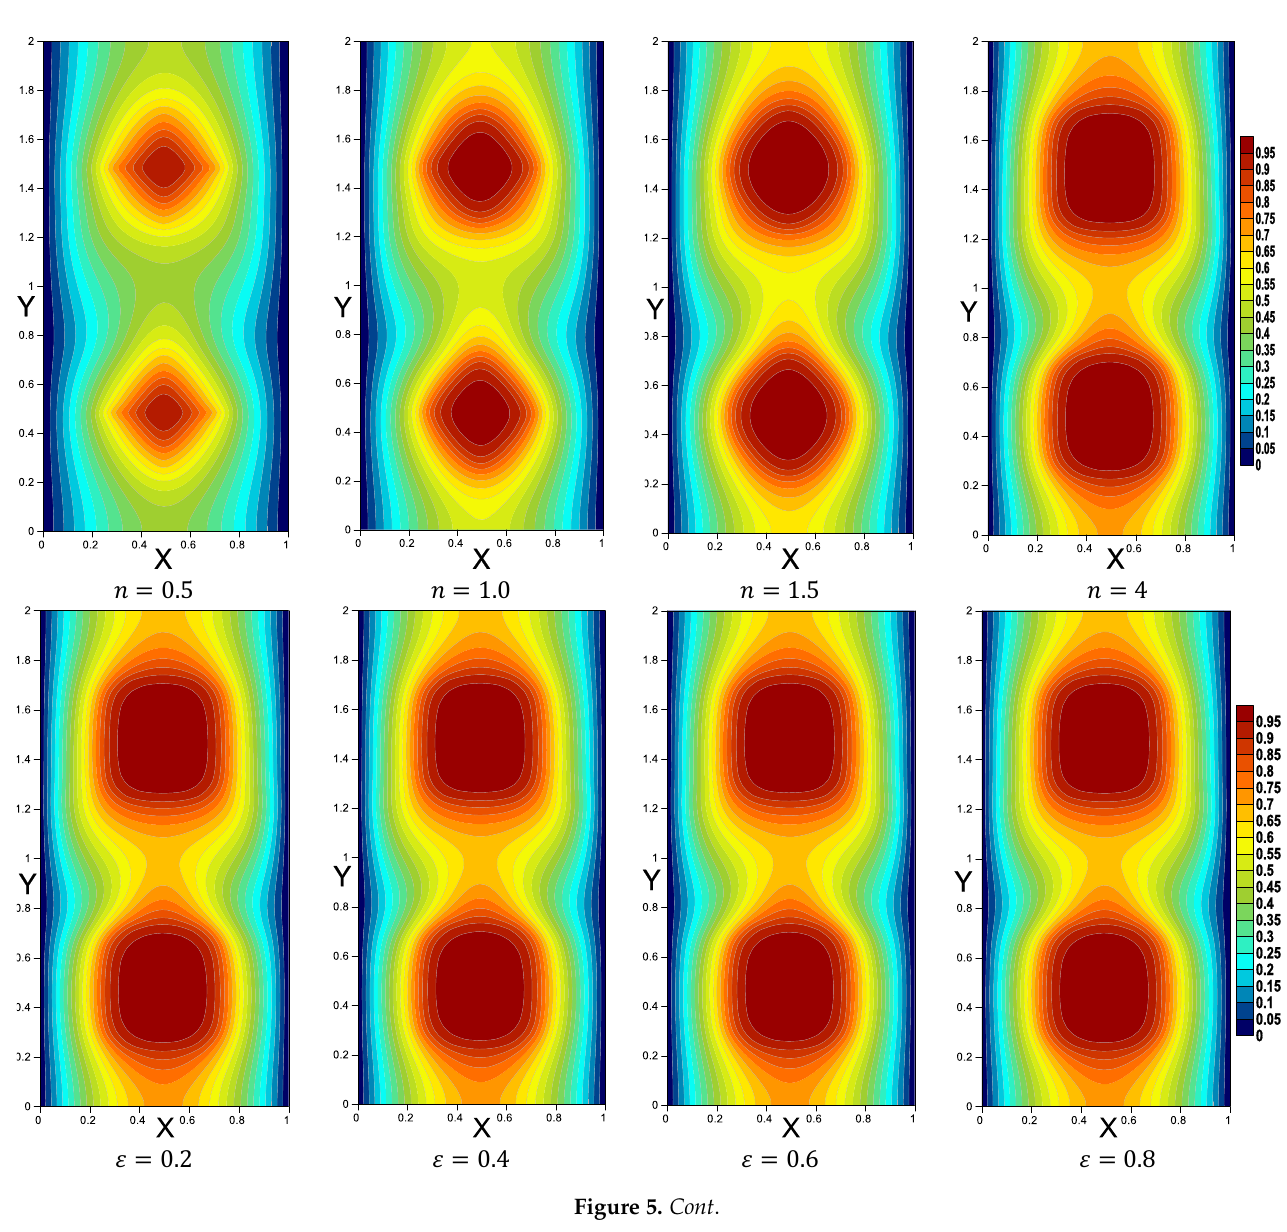
Figure 4. The streamlines below the variations of the shape of superellipse enclosures, porosity, Rayleigh number, and Darcy number,